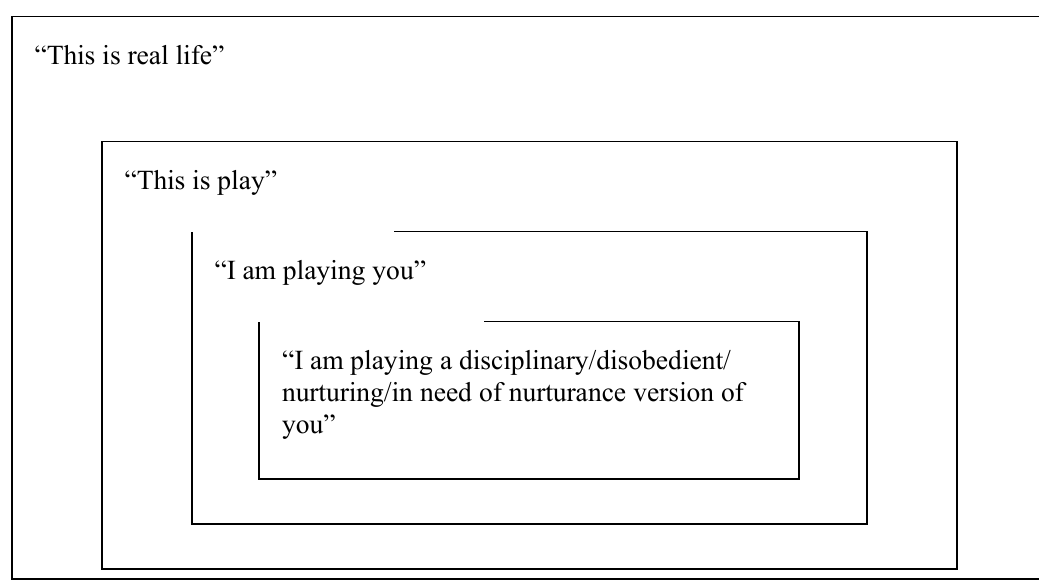
Gordon’s embedded frames for play: three levels of non-literal play (adapted from Gordon, 2002